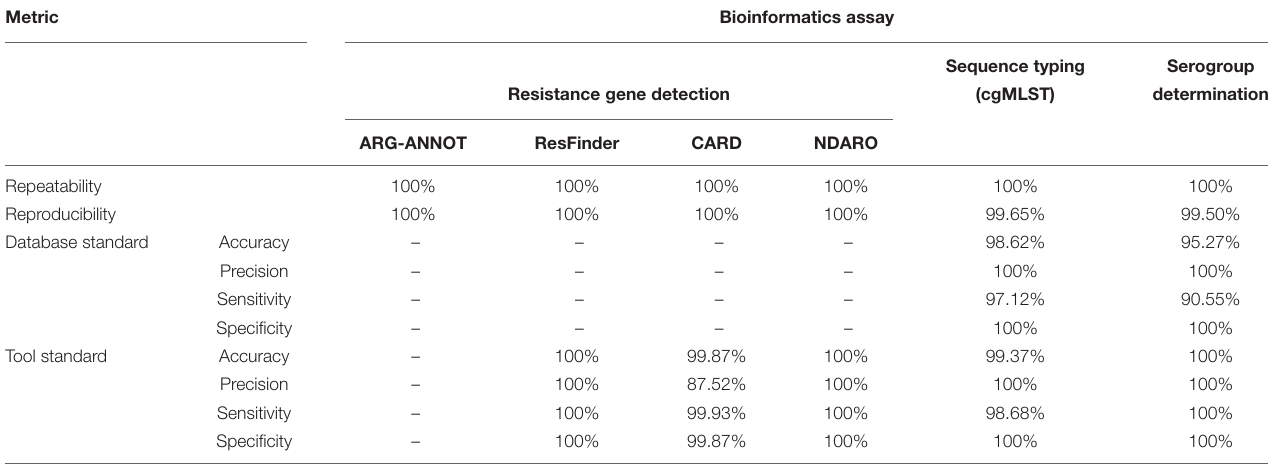
TABLE 4 | Results for the core validation